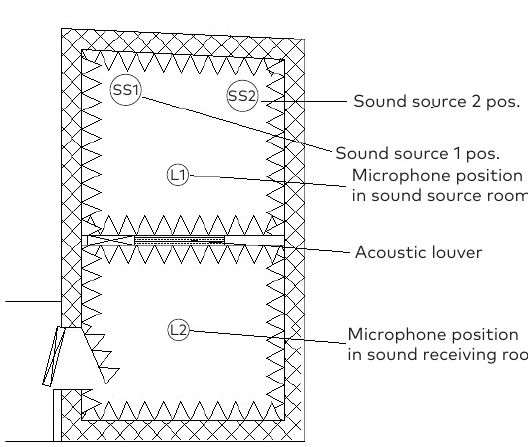
Figure 5. Equipment and tested louvre positions in the